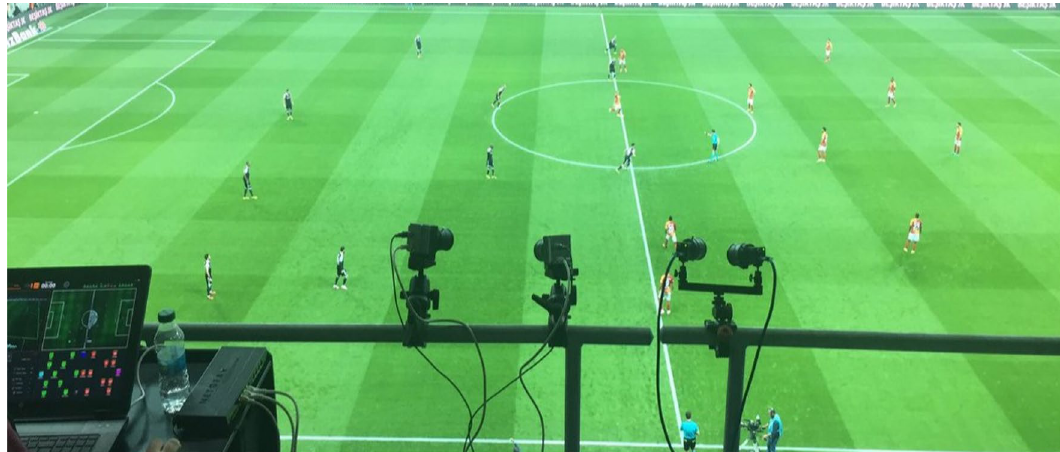
Figure 1. Sentio Sports optical tracking system positioning.